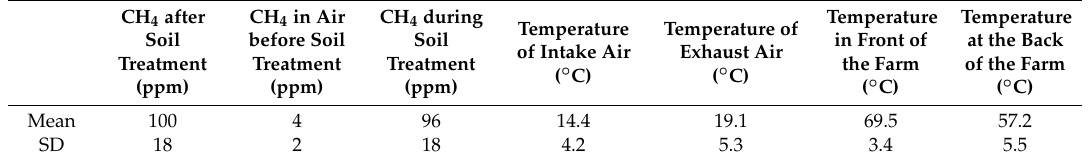
Table 2. Methane concentration and temperature according to process of the night soil treatment.